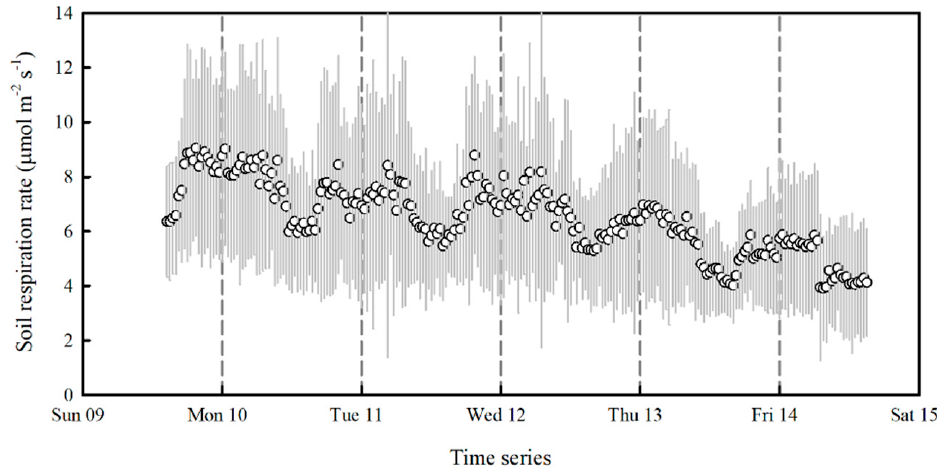
Figure 3. A continuous monitoring of soil respiration rate to show the effect of trenching. Gray shading indicates the standard deviation.